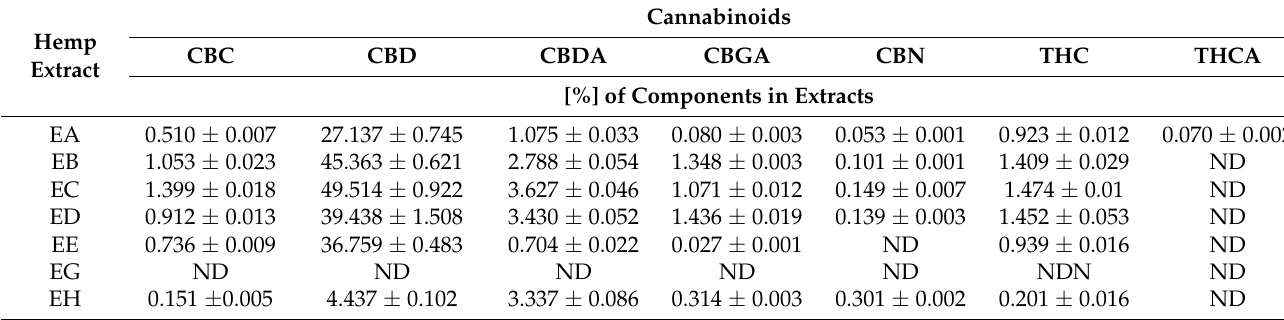
Table 4. Cannabinoids of hemp